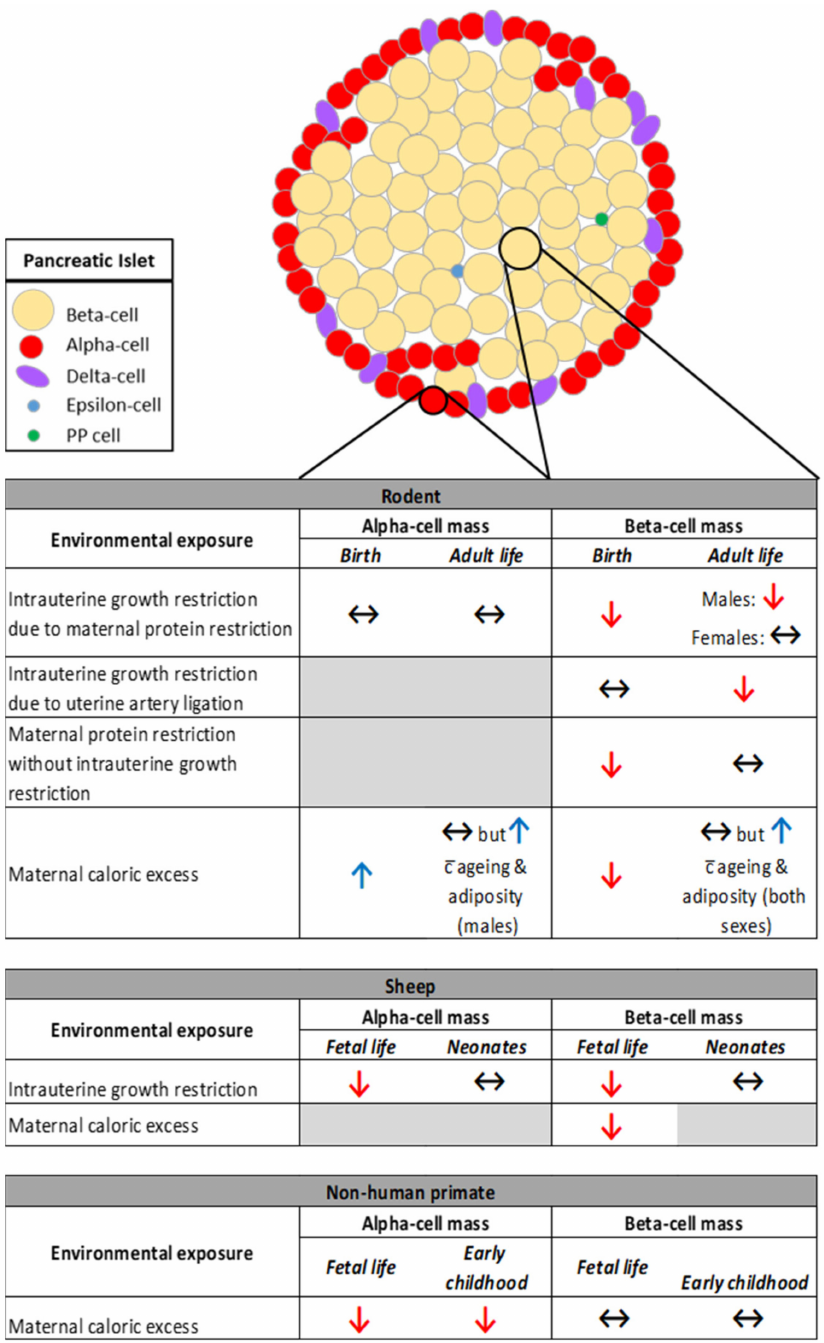
Figure 1. The impact of exposure to restricted nutrition versus caloric excess in rodent, sheep and non-human primate on offspring alpha- and beta-cell mass. Red arrow: Decreased; Blue arrow: Increased; Black arrow: No change; Gray shading indicates data is not available